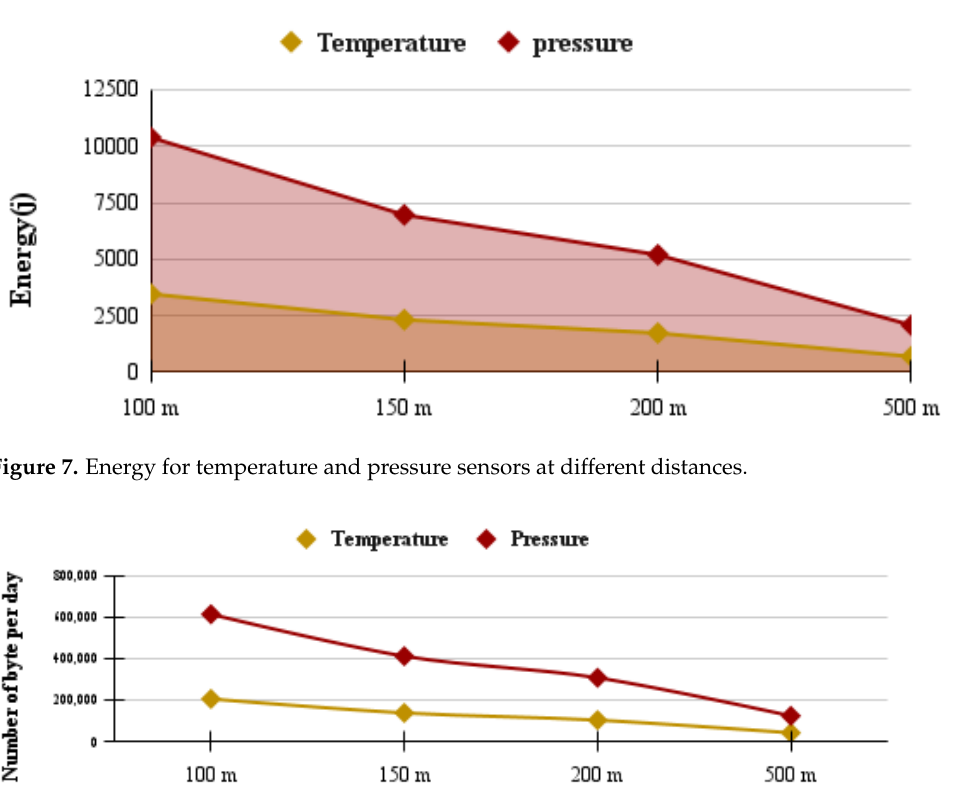
Figure 9. Energy consumption for different topologies.